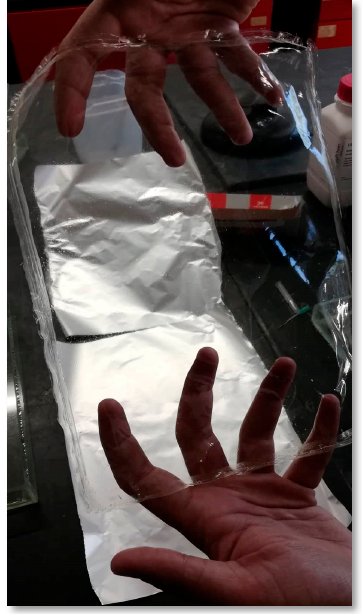
Figure 1. Film obtained by casting method.